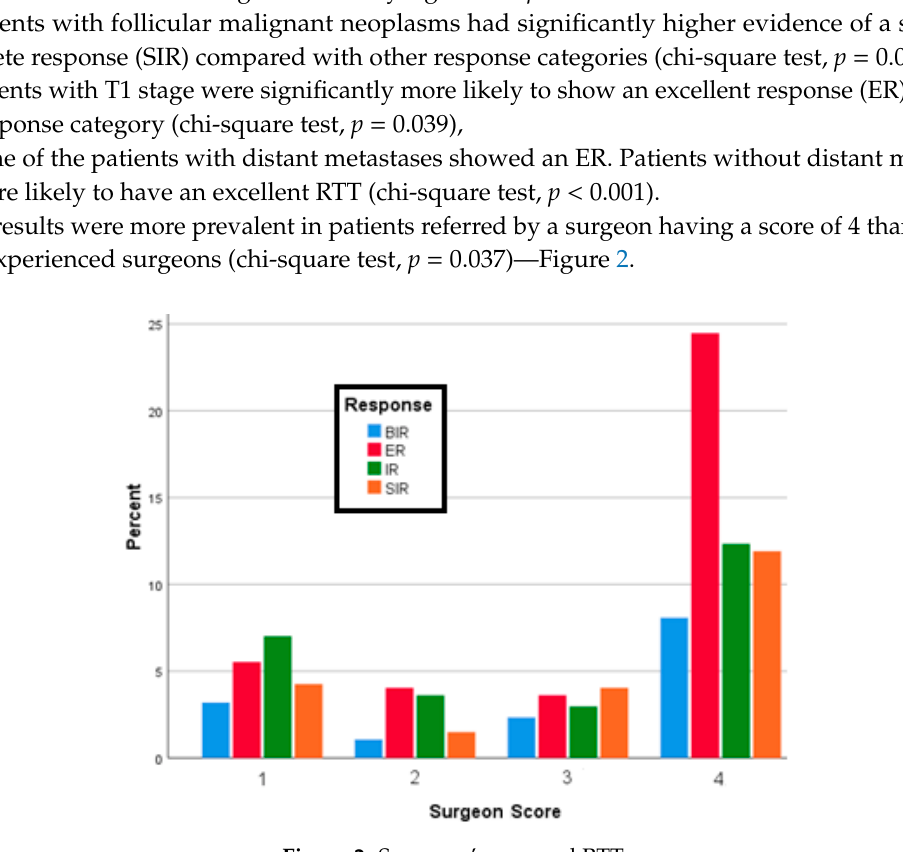
Figure 2. Surgeons’ score and RTT.